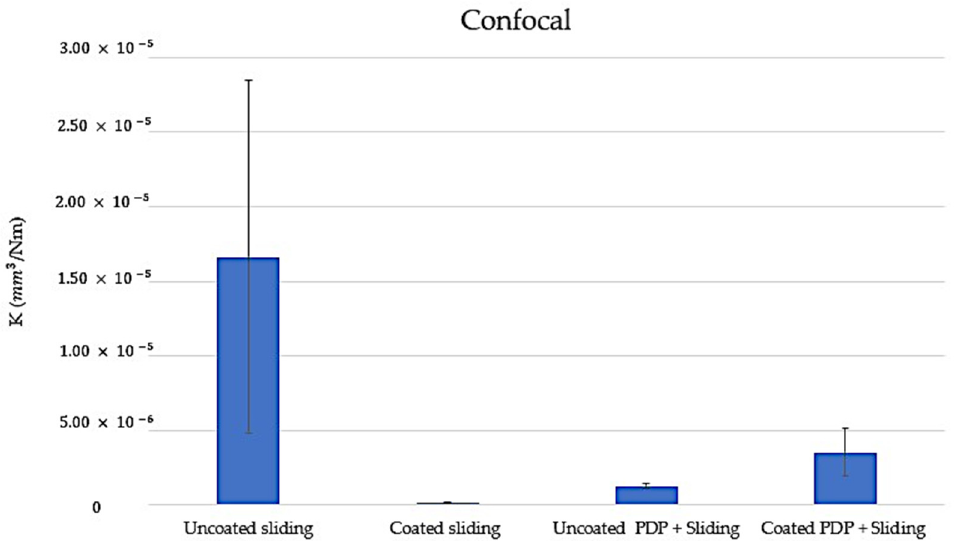
Figure 9. Wear coefficient (K) values measured straight from the volume loss values measured by confocal microscopy for both coated and uncoated samples in dry conditions.